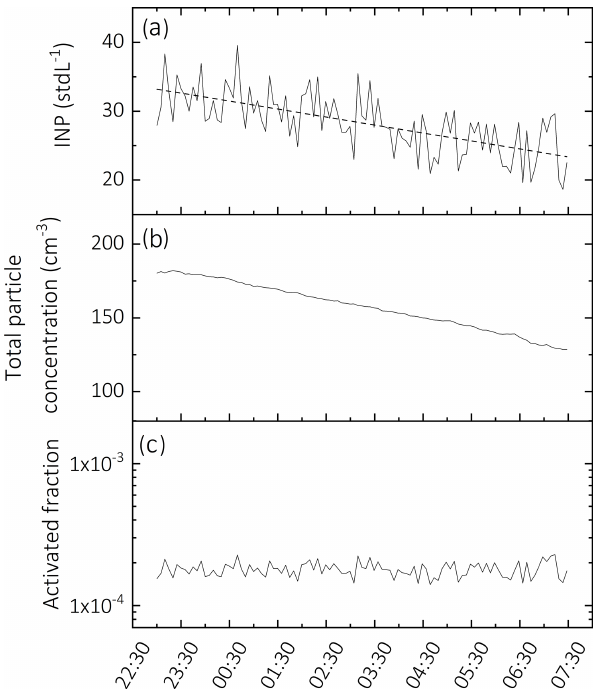
Figure A6. Time series from an experiment with the new commer- cial PINE-04-01 instrument sampling aerosol from the AIDA cloud chamber, with INP concentrations measured at 247.2K (a) , total aerosol particle number concentration measured with a condensa- tion particle counter (b) , and the ice-active particle fraction f ice calculated from the ratio of the INP number concentration to the aerosol number concentration, with a mean value of 1 . 8 × 10 − 4 and a standard deviation of 2 . 1 × 10 − 5